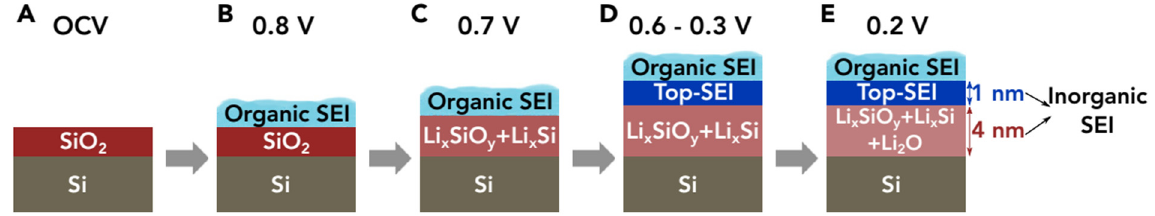
Figure 8. ( A – E ) Schematic drawing illustrating the proposed voltage-dependent SEI growth mech- anism on native oxide-terminated silicon anodes. Reproduced with permission from ref. [16]. Cop- yright 2018, Elsevier.